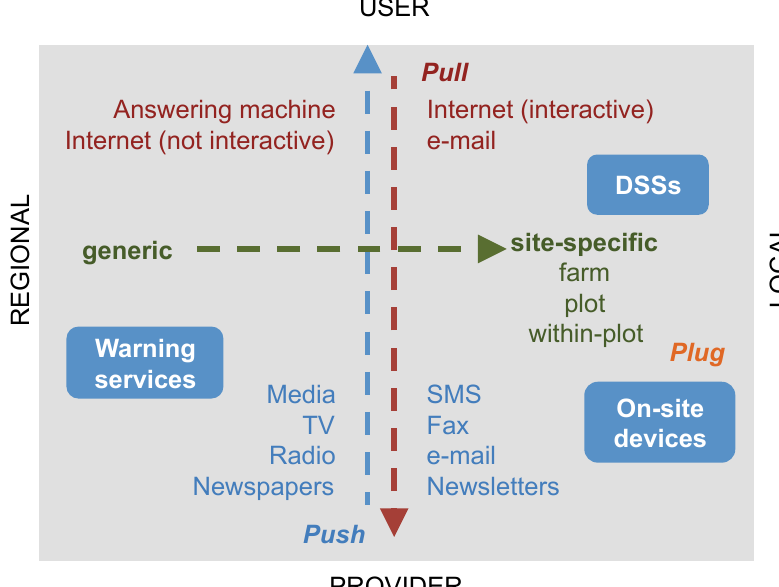
Figure 8. A comparison of spatial scales and delivery mechanisms for decision support tools (warning services, on-site devices, and DSSs) for crop protection (modified from Magarey et al. , 2002). DSSs = decision support